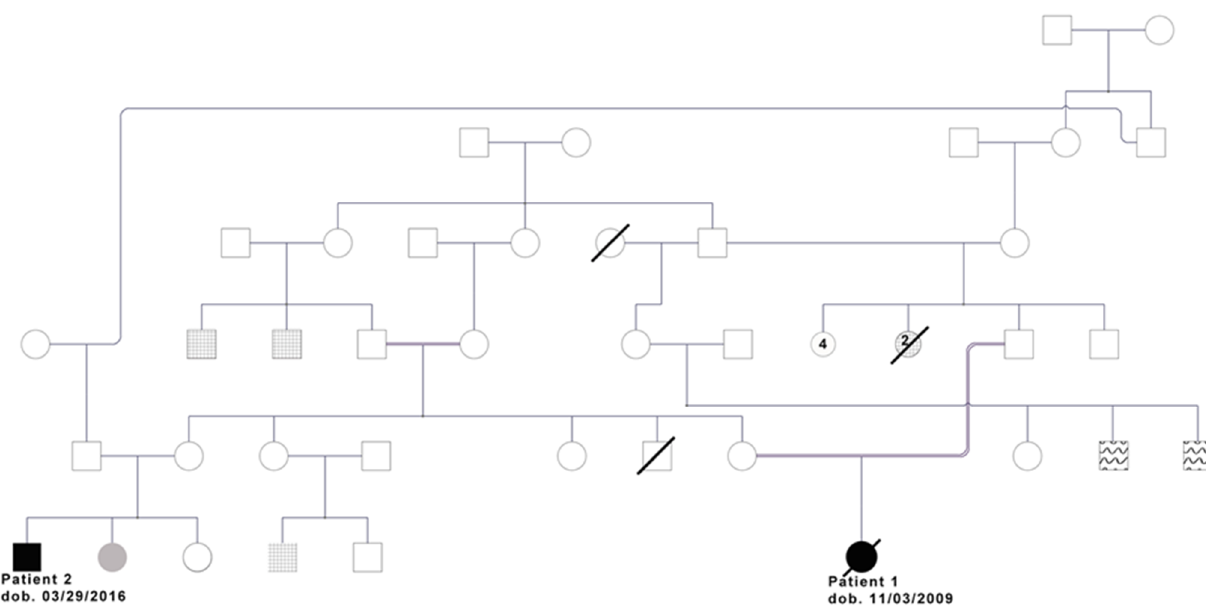
Figure 1. Extended family pedigree showing the relations among all four progenitors, the two mothers being sisters, and the two fathers being cousins once removed. Patient 1’s parents are also cousins once removed (connected through a double bond). Patients 1 and 2 in black. Patient 2’s microcephalic sister in grey. Squared pattern: congenital deafness. Wavy pattern: intellectual disability.